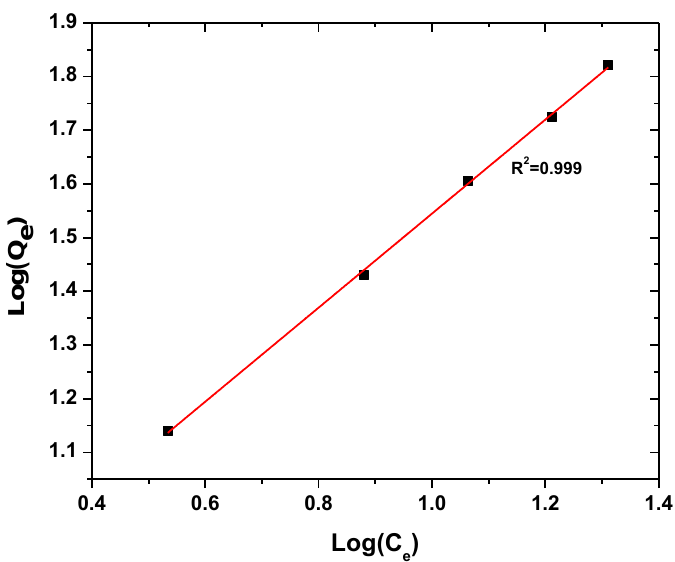
Figure 12. Freundlich isotherm plot of dye adsorption on BFO/CFO@PEG nanocomposites. Experimental condition: initial dye concentration 20–100 mg/L, initial solution pH 2, adsorbent dosage 0.06 g/L, and contact time 40 min.